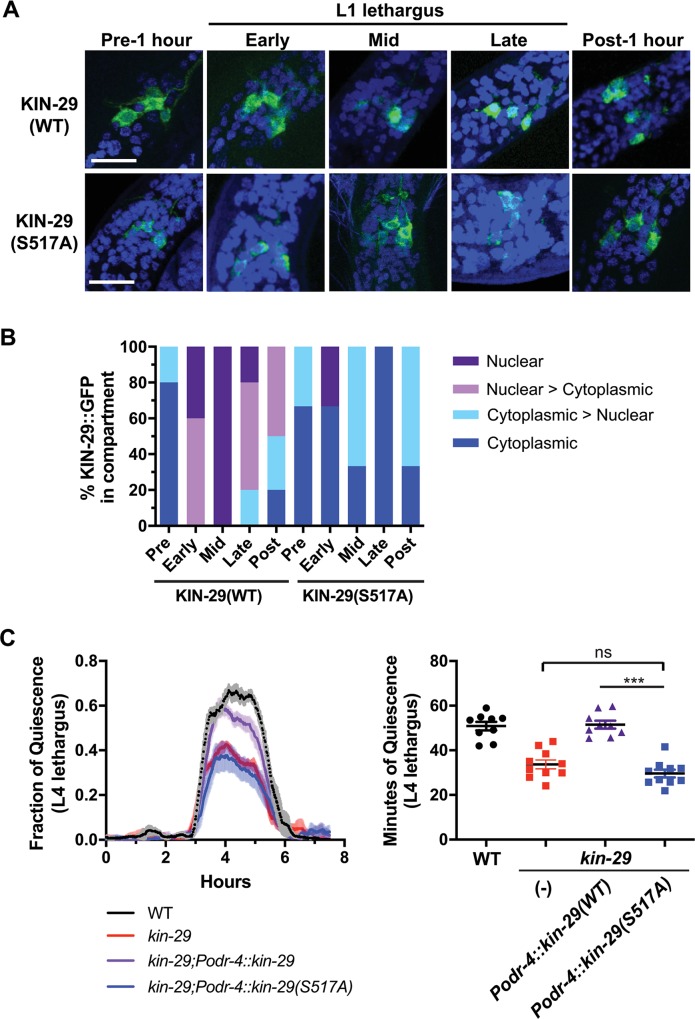
KIN-29(S517A) mutant does not translocate to the nucleus during sleep and does not rescue the short-sleeping phenotype of kin-29.(A) Confocal images of KIN-29::GFP in odr-4(+) neurons (green) of WT animals. Nuclei are identified by blue DAPI staining. One hour prior to L1 lethargus and 1 hr after L1 lethargus (n = 3–5 animals for each condition), KIN-29::GFP is mostly cytoplasmic. During mid and late L1 lethargus (n = 5–7 animals for each condition), KIN-29, but not the KIN-29(S517A) mutant, localizes to the nucleus of a subset of odr-4(+) neurons. Scale is 10 μm. (B) Percentage of KIN-29::GFP in the subcellular compartment of odr-4(+) neurons before, during, and after lethargus/DTS of the L1 stage. Shown is the percentage of animals that show fully nuclear, intermediate (nuclear > cytoplasmic, and cytoplasmic > nuclear), and fully cytoplasmic location of GFP (S1 Data, Sheet 7B). (C) The KIN-29(S517A) mutant does not rescue the reduced L4 lethargus/DTS of kin-29 null mutants. Left graph: The fraction of quiescence in a 10-min moving window is shown with n = 3 animals for the WT trace, n = 4 animals for the kin-29 trace, n = 8 animals for the Podr-4::kin-29(S517A) trace, and n = 6 animals for the Podr-4::kin-29(WT) trace. The x-axis represents hours from the start of recording in the late L4 stage. The data from individual worms were aligned such that the start of lethargus quiescence occurred simultaneously. Shading indicates SEM. Right graph: Total body movement quiescence during L4 lethargus/DTS determined from the time-course data. Data are represented as the mean ± SEM. ***p < 0.001 by an ANOVA with Tukey multiple-comparisons test (S1 Data, Sheet 7C). DAPI, 4,6-diamidino-2-phenylindole; DTS, developmentally timed sleep; GFP, green fluorescent protein; L1 stage, first larval stage; L4 stage; fourth larval stage; ns, not significant; WT, wild type.